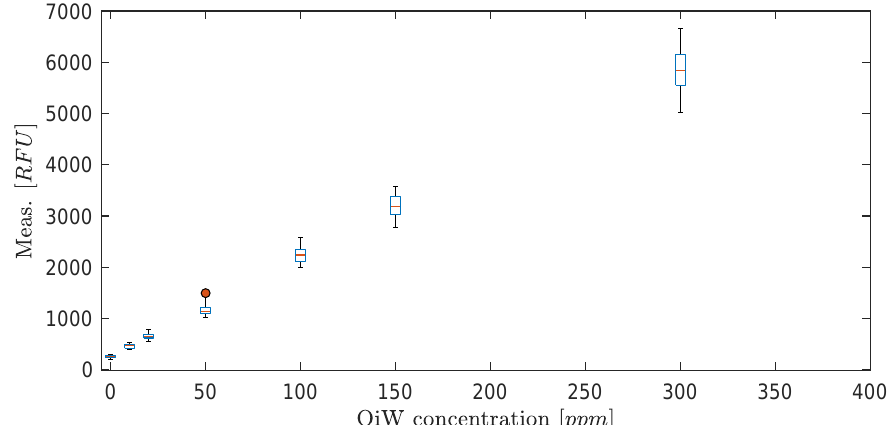
Figure 2. Combined box plot at each oil-in-water (OiW) concentration of all four OiW monitors’ calibration data. The calibration data consist of 280; 70 samples for each OiW monitor at following OiW concentrations: 0, 10, 20, 50 100, 150, 300